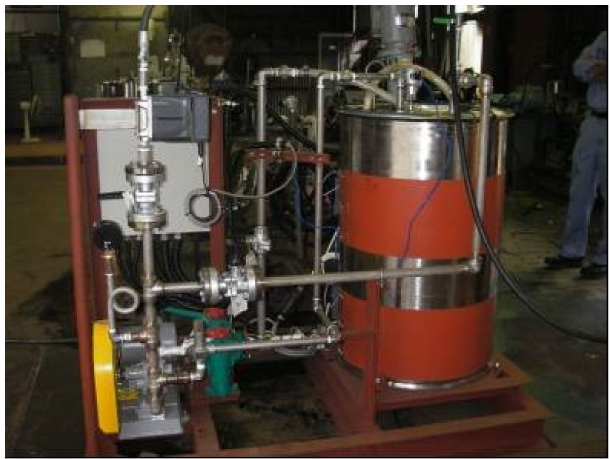
Figure 5. Bio-oil and A-fuel oil co-combustion test